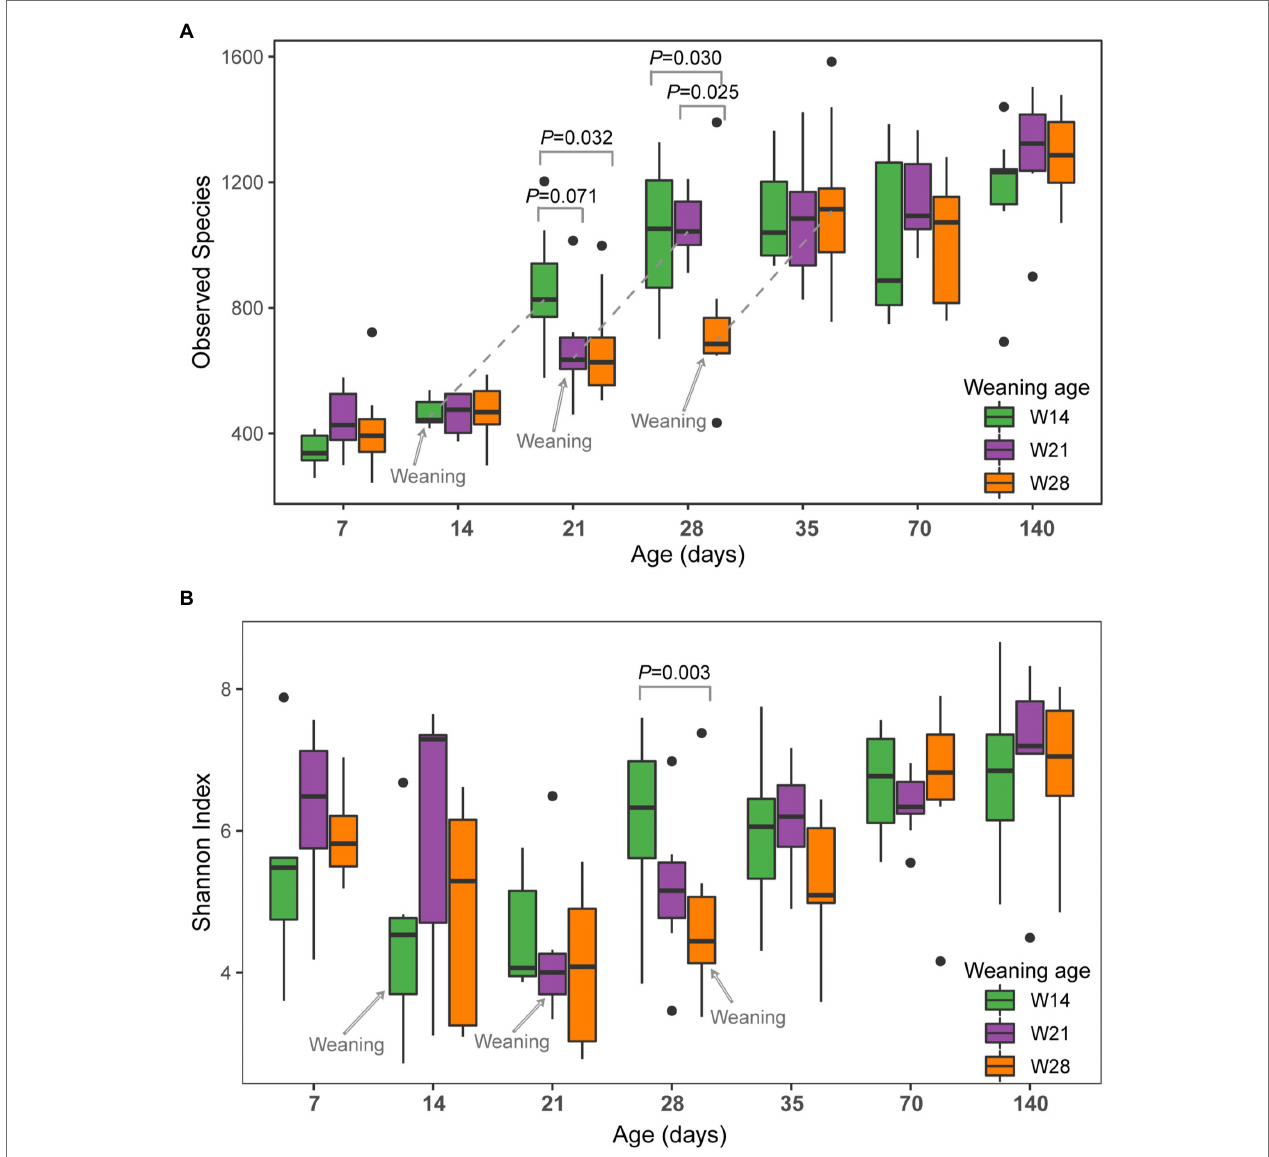
FIGURE 1 | Archaeal alpha diversity in the swine gut grouped by weaning age over time. (A) Observed species, (B) Shannon Index. Colors of green, purple, and orange represent different weaning time groups on day 14 (W14), day 21 (W21), and day 28 (W28). Significance determined by Kruskal–Wallis (pairwise) test. Values of p between groups are labeled above groups when p ≤ 0.05. There is no difference between groups ( p > 0.05) if not indicated